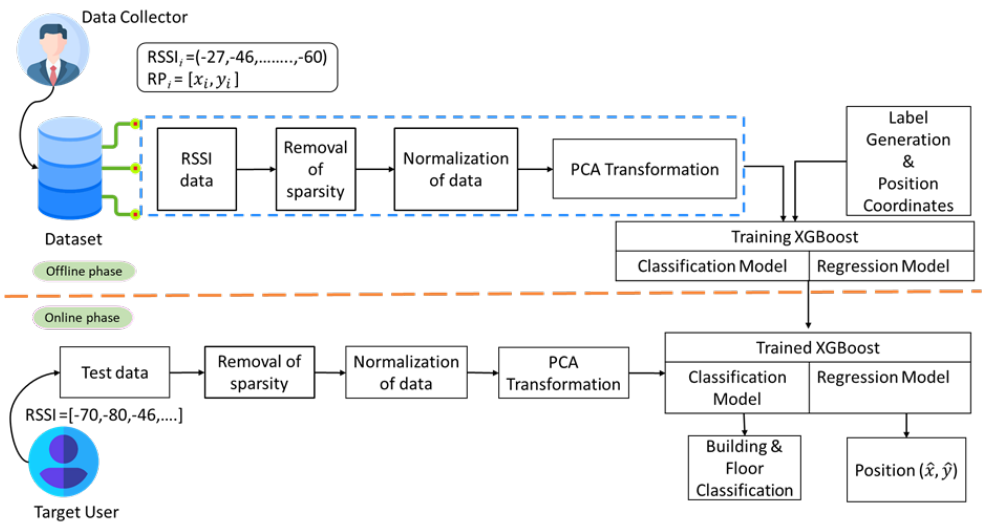
Figure 2. Architecture of proposed system model XGBLoc.